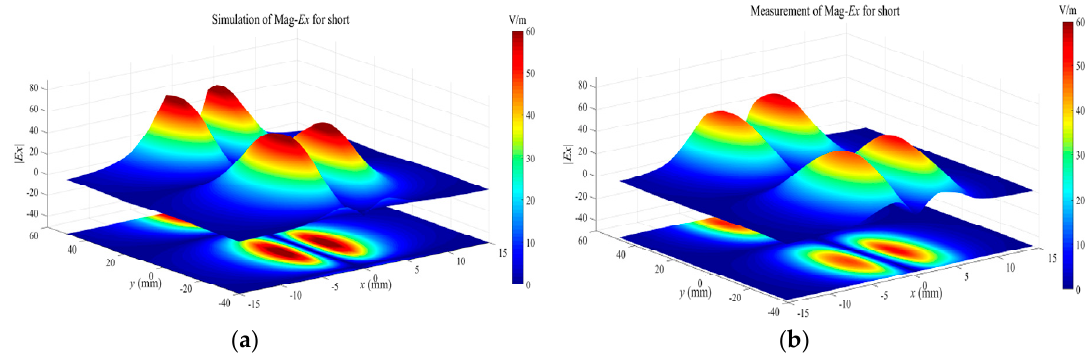
Figure 23 . ( a ) The simulated and ( b ) measured Ex-field distributions at the height of 2 mm over the microstrip line in the short state.